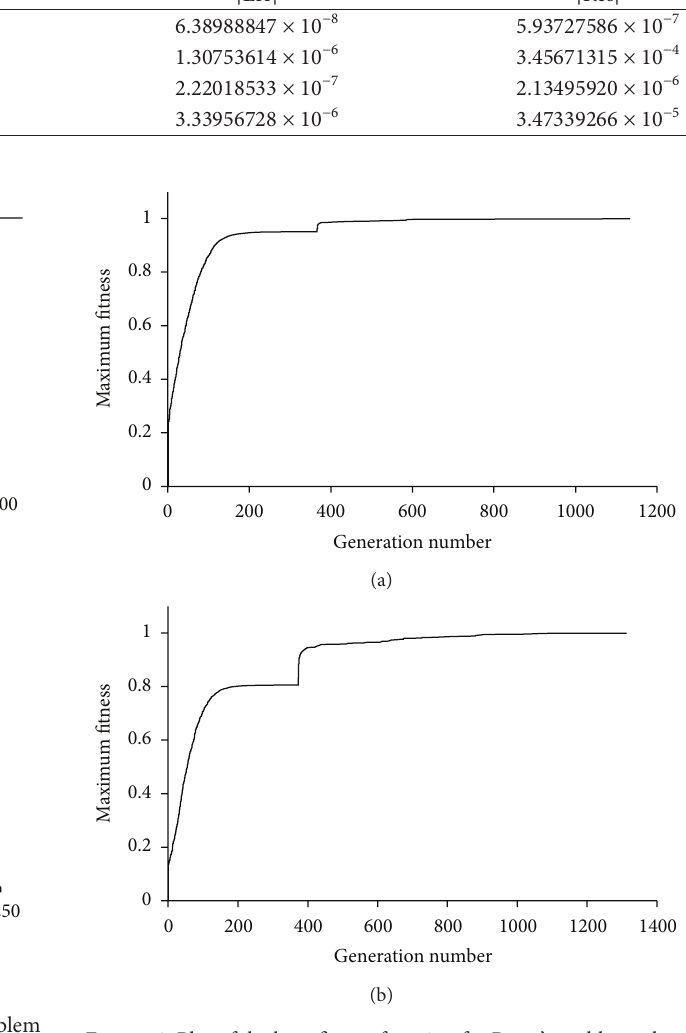
Figure 3: Plot of the best-fitness function for Bratu’s problem when (a) 𝜇 = 1 and (b) 𝜇 = 2